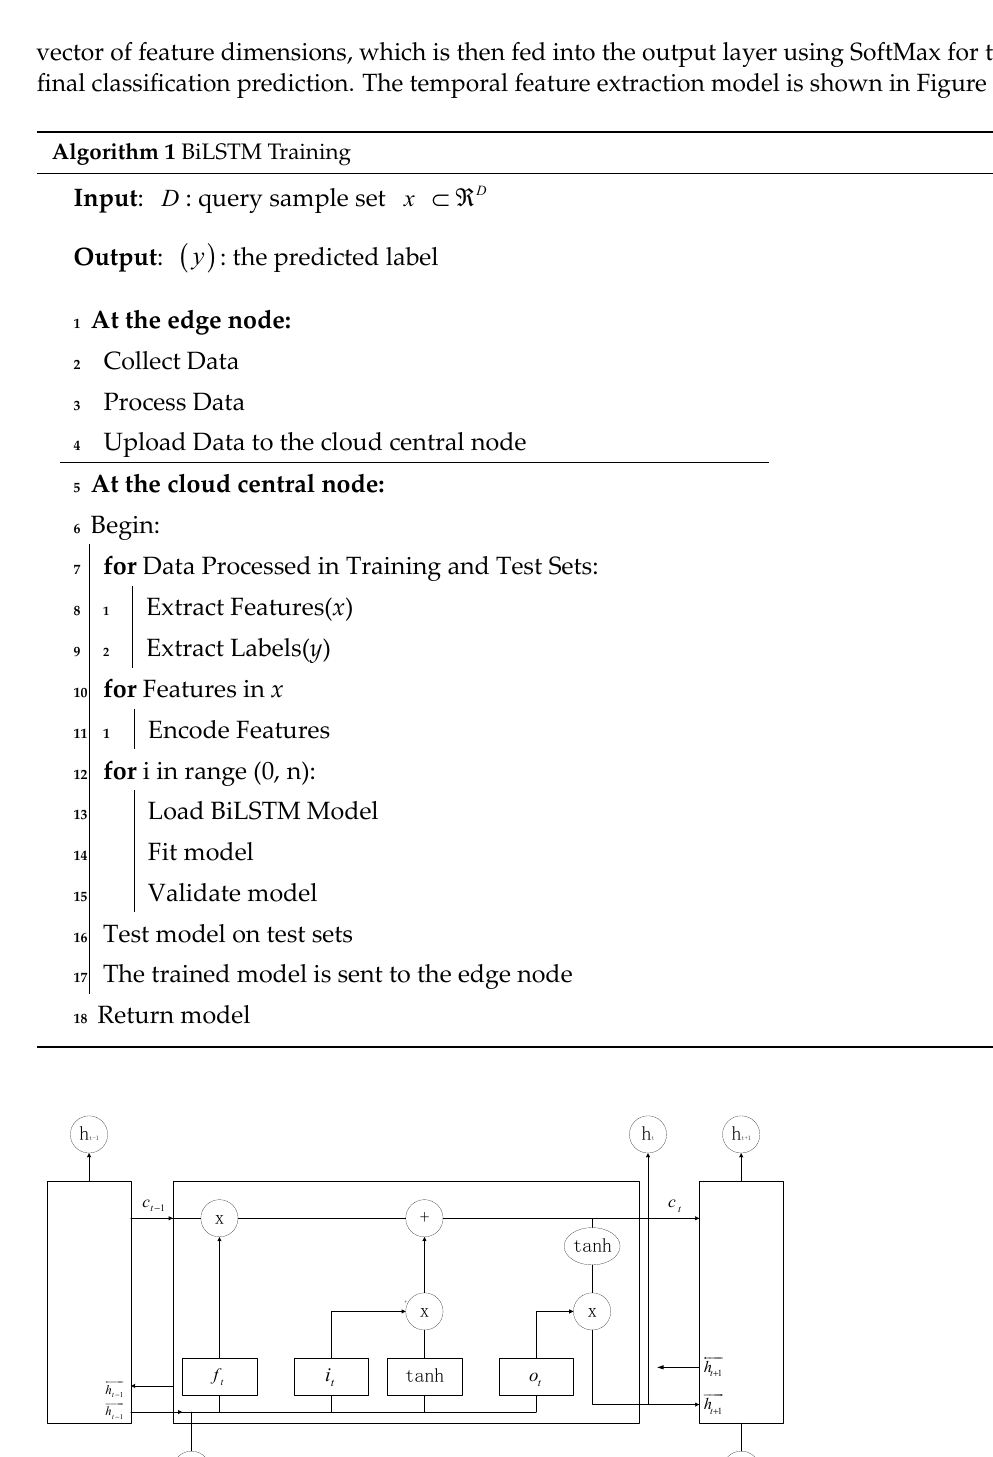
Figure 5. Schematic diagram of BiLSTM structure.